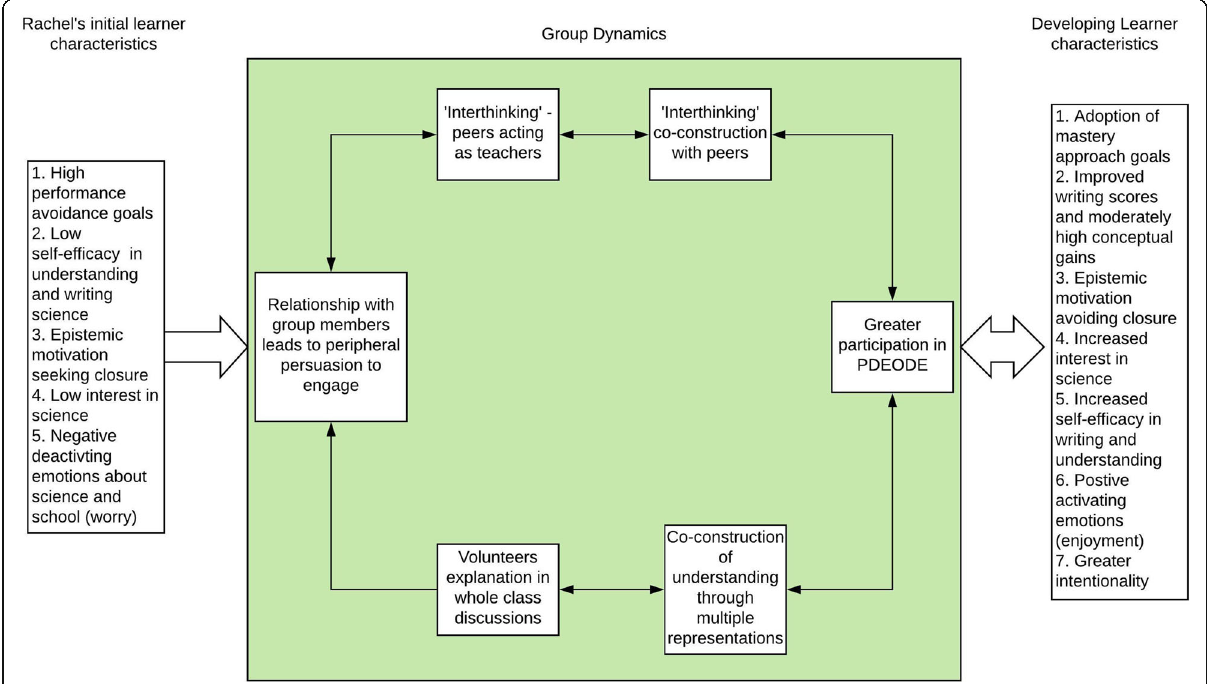
Fig. 1 Interactions between Rachel ’ s student characteristics and the social environment and the resulting outcomes in the cognitive and affective